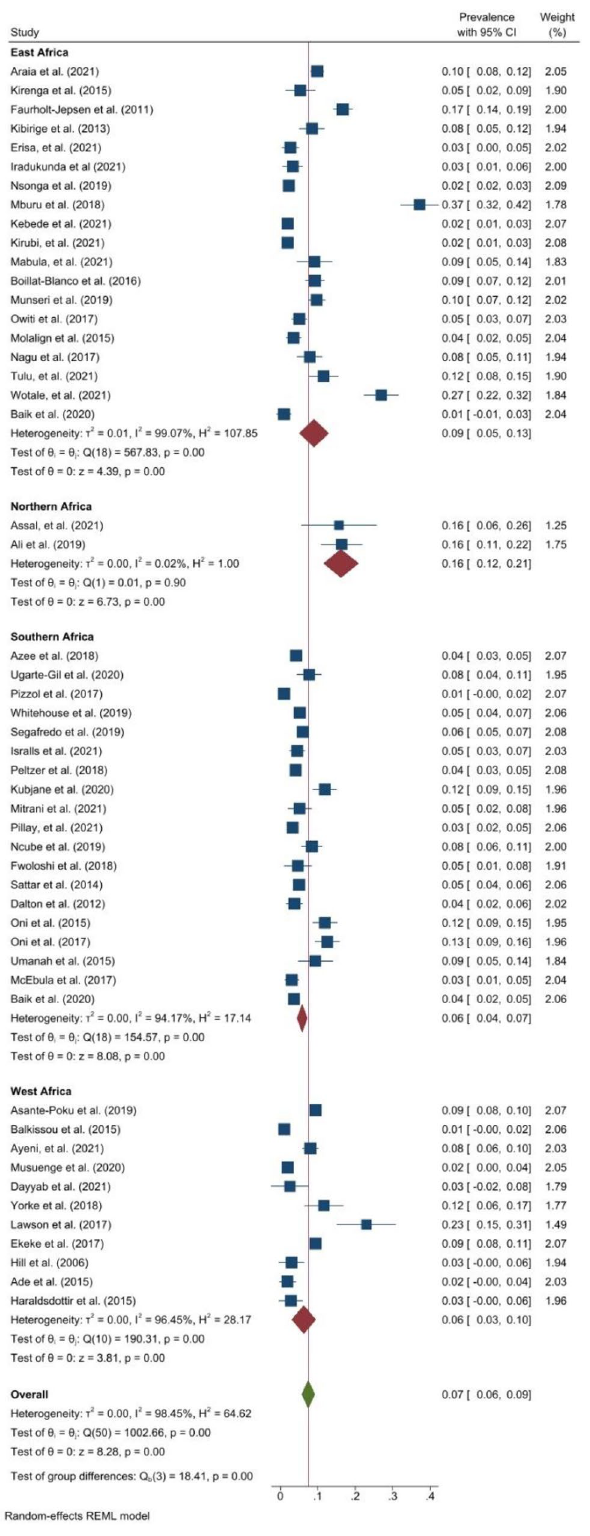
Figure 4. Forest plot showing the prevalence of DM among people with active TB in